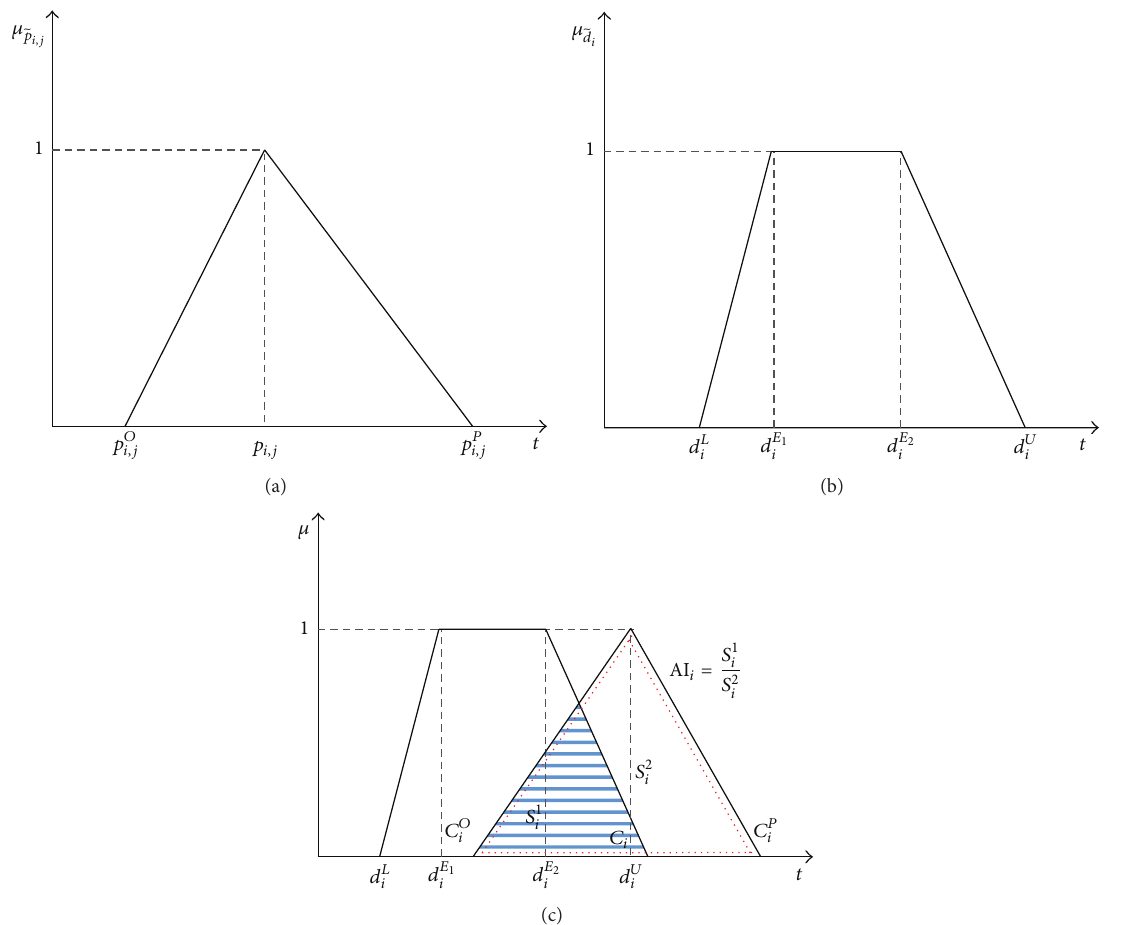
Figure 2: (a) Membership function of the triangular fuzzy processing time; (b) membership function of the trapezoidal fuzzy due date; (c) agreement index